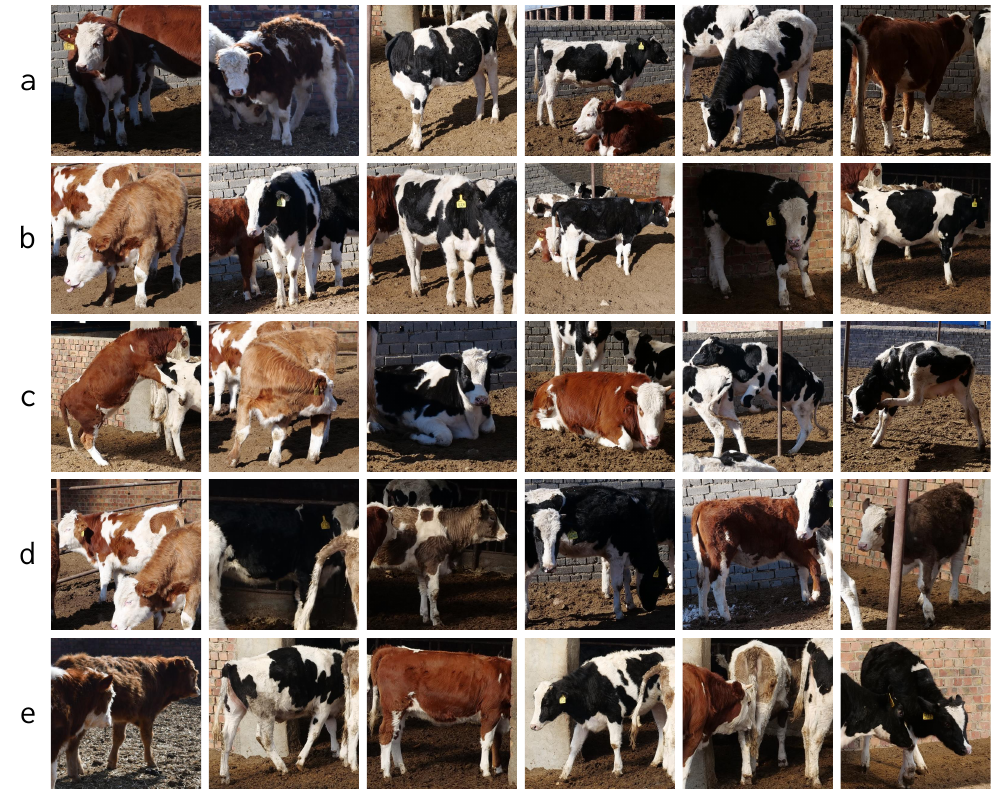
Figure 8. CAIDRE dataset examples. The CAIDRE dataset contains 27 individuals, including not only Chinese Simmental, but also Holstein Friesian cattle in several scenarios. It faces the difficulties of identification for a more complex background (Lines a and b ), different postures (Line c ), and partially occlusion with structures or other animals (Lines d and e ). The samples are more complicated and realistic with real farming conditions than in the CNSID100 dataset. Best viewed in